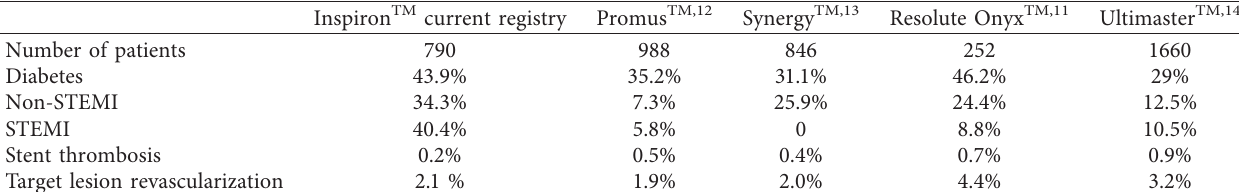
Table 4: Comparison between Inspiron and other DES (1-year